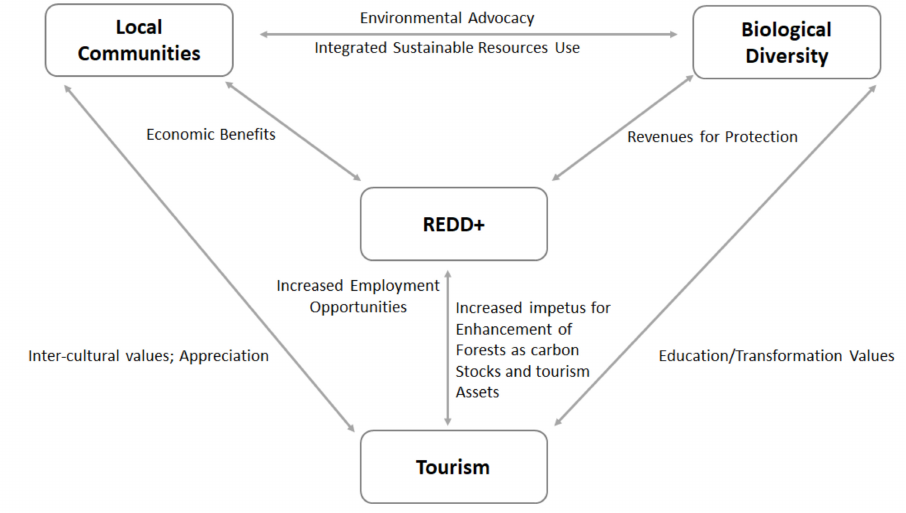
Figure 1. Relationship between local communities, biodiversity, ecotourism, and REDD + (adapted from [18], modified from